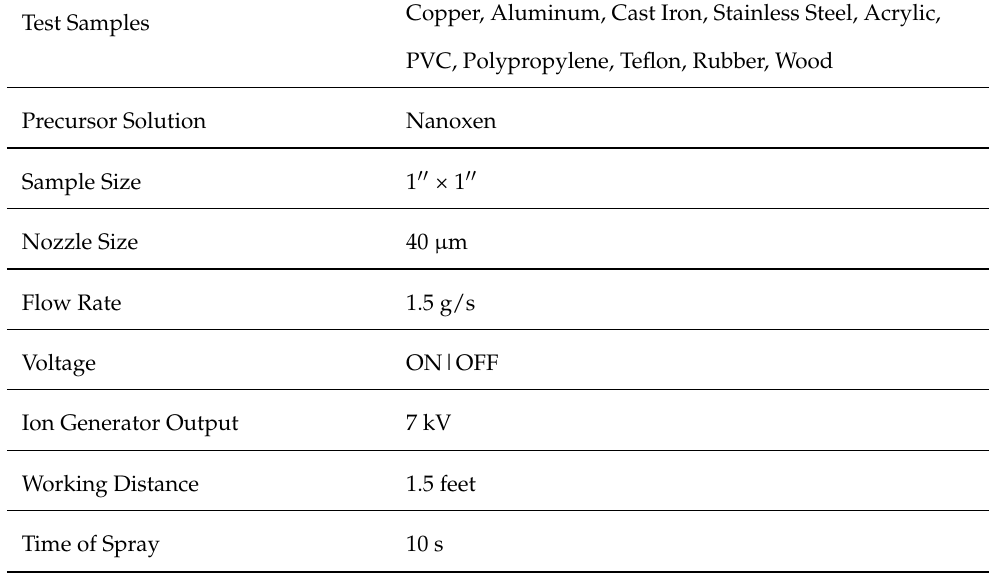
Table 1. Sample preparation for SEM